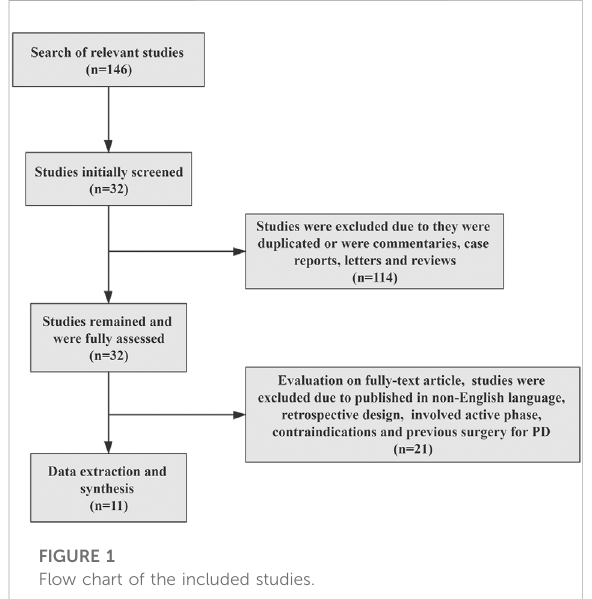
FIGURE 1 Flow chart of the included